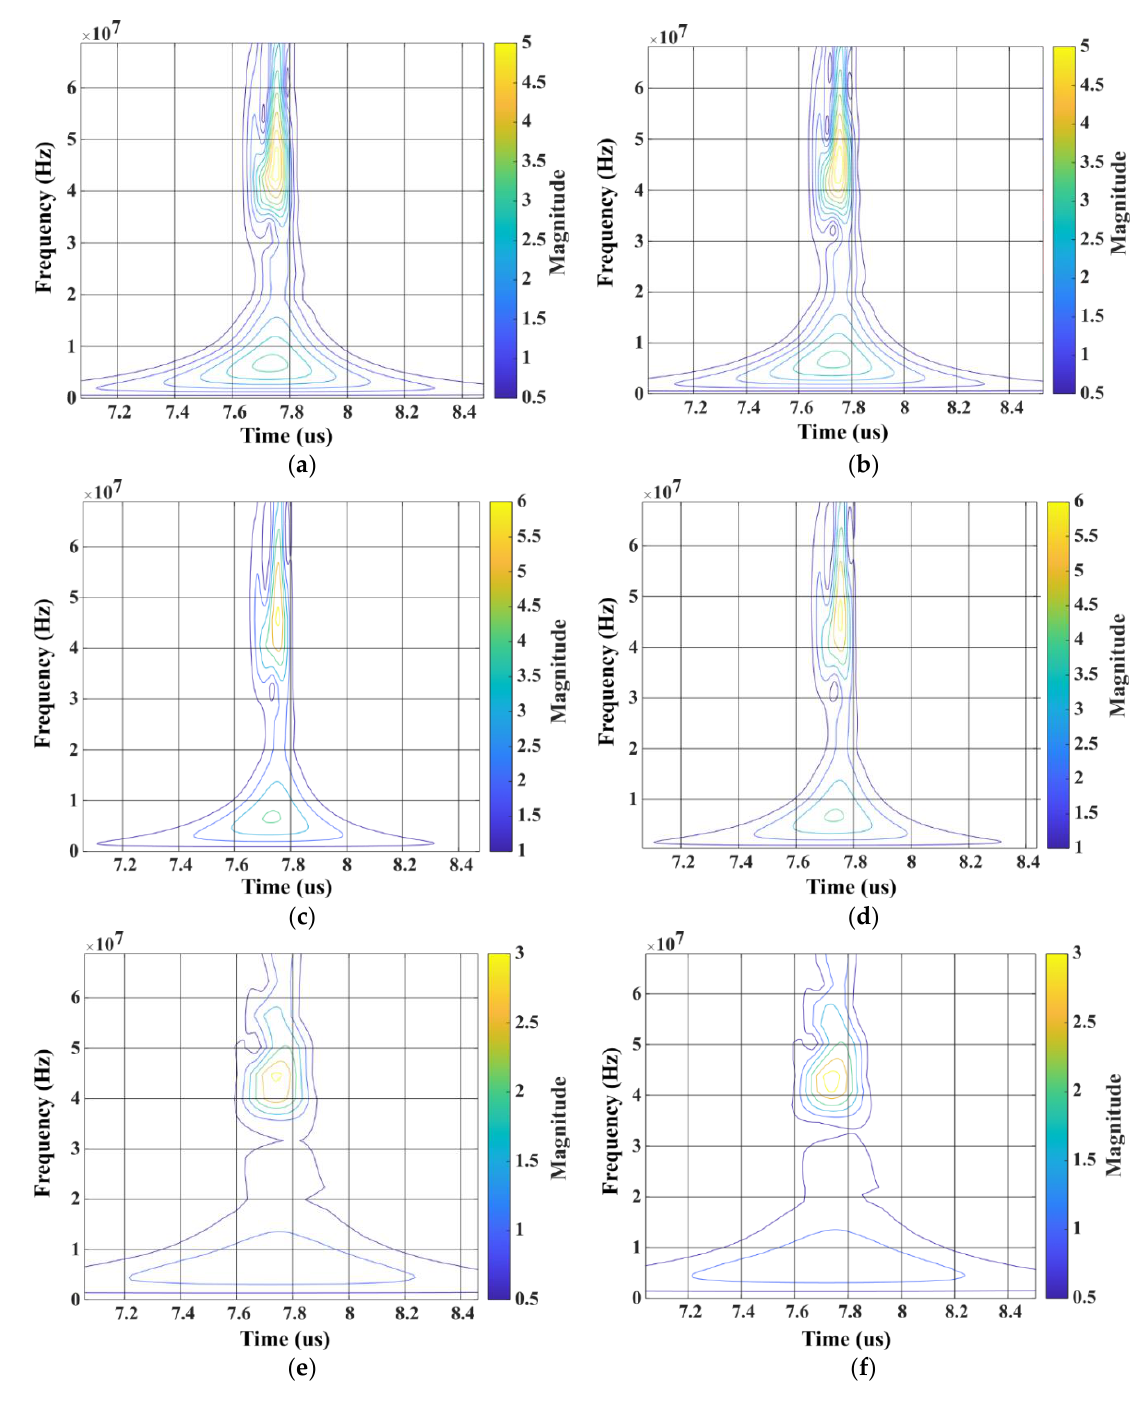
Figure 9. Wavelet analysis comparison using different wavelet types, number of octaves ( 𝑁 𝑜 ) and number of voices ( 𝑁 𝑣 ): ( a ) Morse wavelet 𝑁 𝑜 = 13 , 𝑁 𝑣 = 6 ; ( b ) Morse wavelet 𝑁 𝑜 = 13 , 𝑁 𝑣 = 40 ; ( c ) Morlet wavelet 𝑁 𝑜 = 13 , 𝑁 𝑣 = 6 ; ( d ) Morlet wavelet 𝑁 𝑜 = 13 , 𝑁 𝑣 = 40 ; ( e ) bump wavelet 𝑁 𝑜 = 11 , 𝑁 𝑣 = 6 ; ( f ) bump wavelet 𝑁 𝑜 = 11 , 𝑁 𝑣 = 40 .